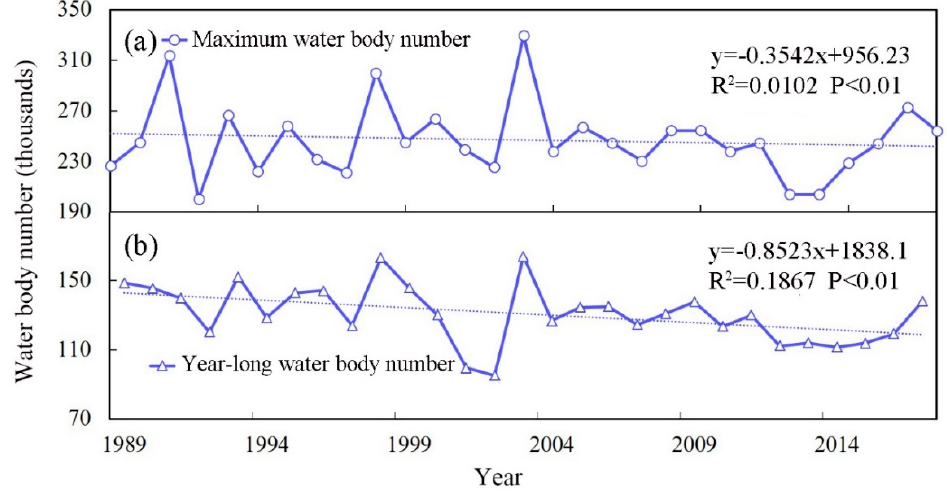
Figure 7. The inter-annual variations of water body numbers across the Huai River Basin from 1989 to 2017: The numbers of maximum water body ( a ) and year-long water body( b ).